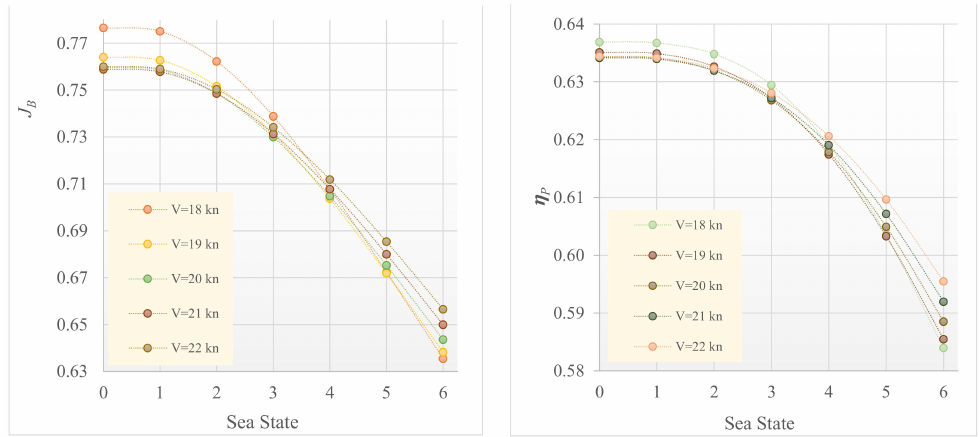
Figure 5. Propeller advance ratio ( left ) and propeller efficiency ( right ) for different sailing speeds and sea states.